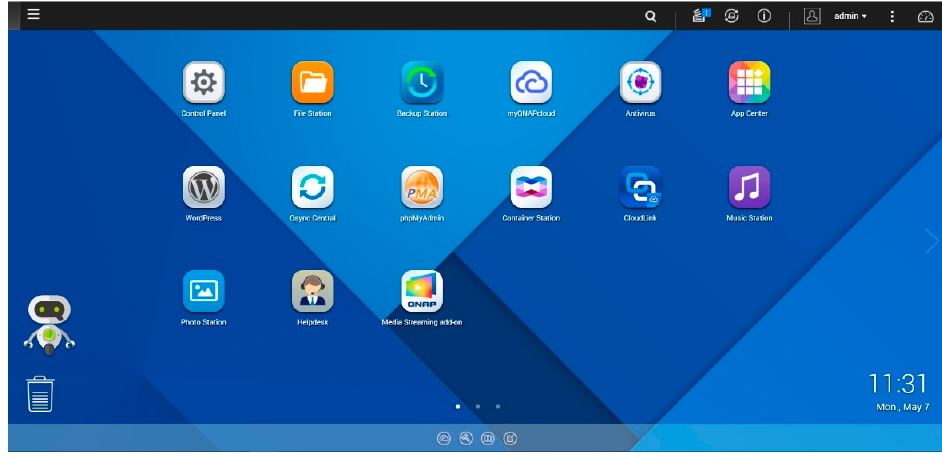
Figure 2. Back ‐ end interface. Figure 2. Back-end interface.